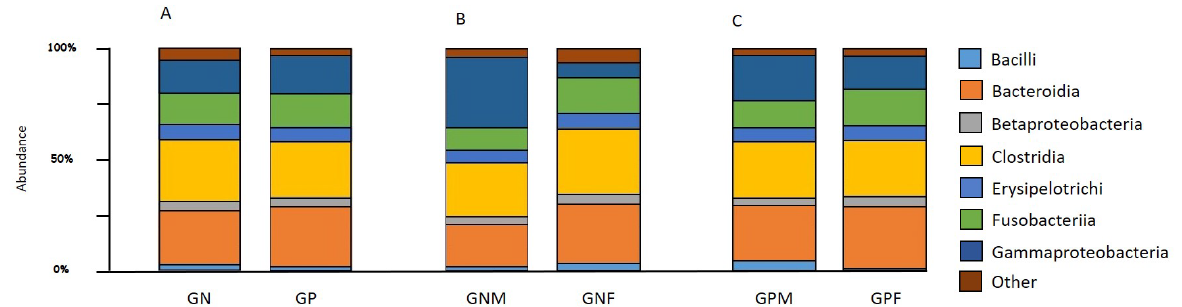
Figure 2. Barplots showing the average abundance of bacterial taxa at the order level between